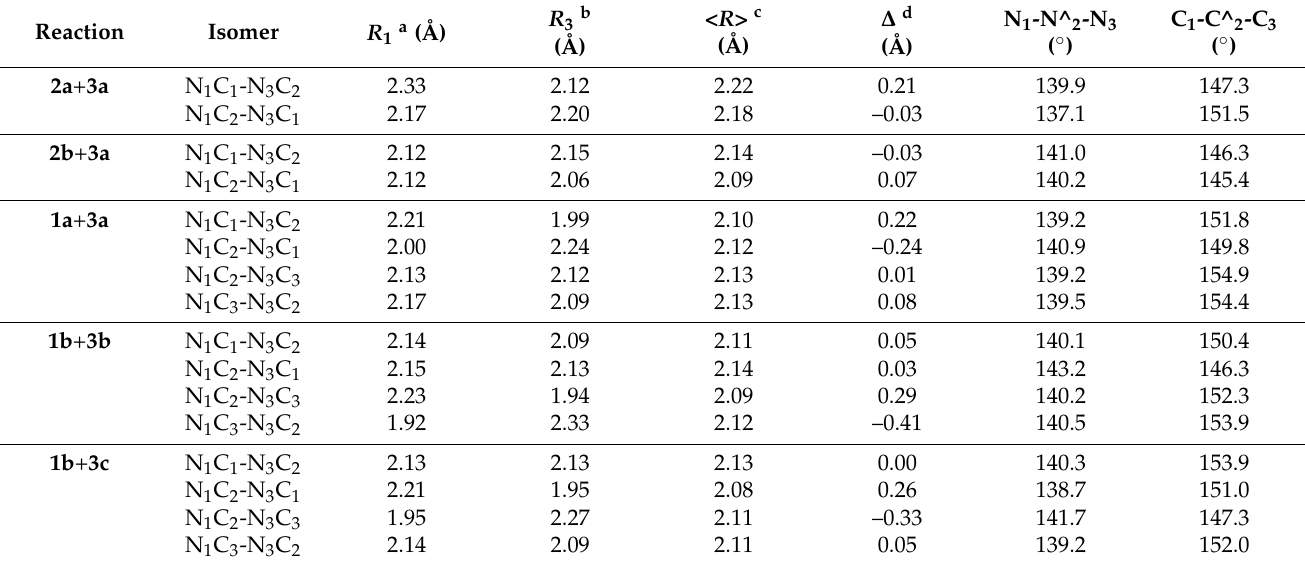
Table 5. Selected geometrical parameters of the TSs calculated at the M08-HX/pcseg-2level. Reaction